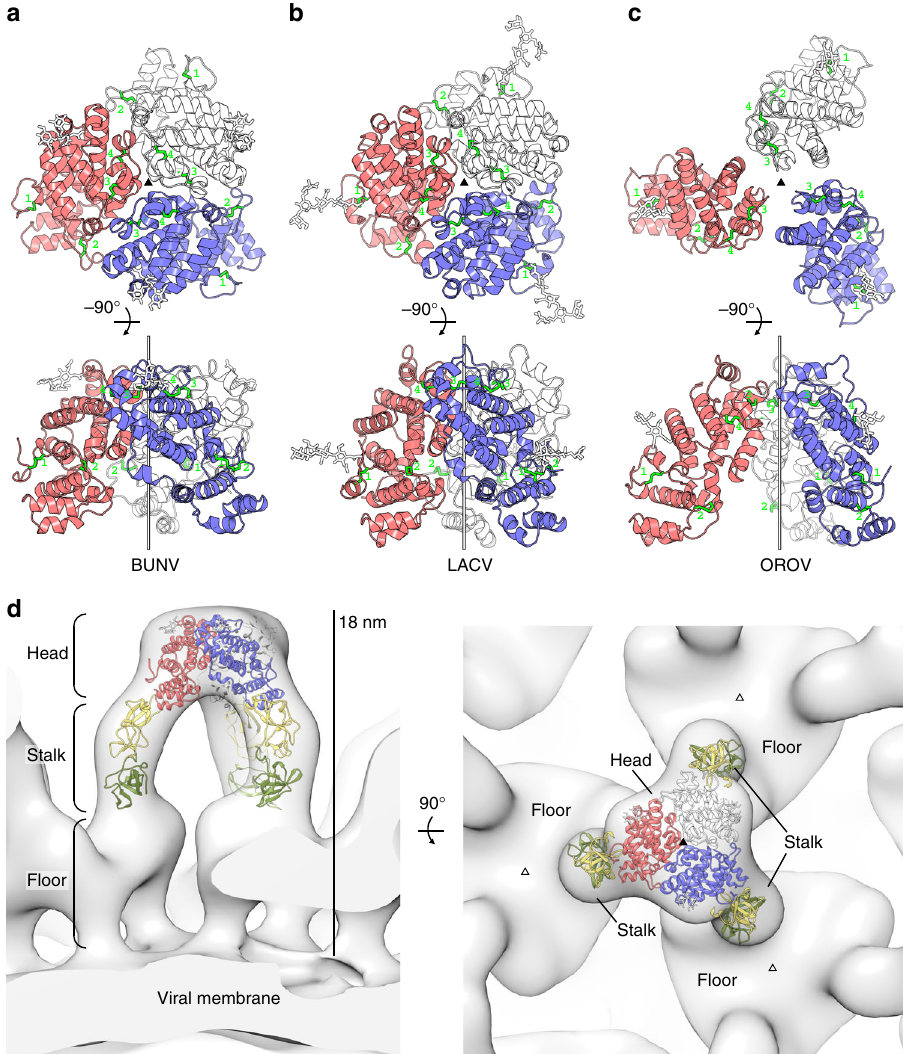
Fig. 2 The head and stalk domains form the trigonal pyramid of the OBV envelope. a – c Trimeric head domain assemblies as found in the crystal structures for a BUNV, b LACV, and c OROV. Trimers are shown in top view (top) and in side view (below). The threefold crystallographic axes are indicated as fi lled triangles (top views) and as vertical bars (side views). The three identical protomers are shown in blue, red, and white, respectively. Disul fi de bonds are shown in bright green; carbohydrate chains are shown as white sticks. d Position of head and stalk within the electron cryo-tomography map of the BUNV glycoprotein spike 17 . The displayed model is composed of the trimeric BUNV head domain structure as in panel a and of the stalk from SBV as in Fig. 1b. The spike is shown in side view (left) and in top view (right). The two non-equivalent threefold symmetry axes within the local structure of the envelope are indicated as fi lled and empty triangles